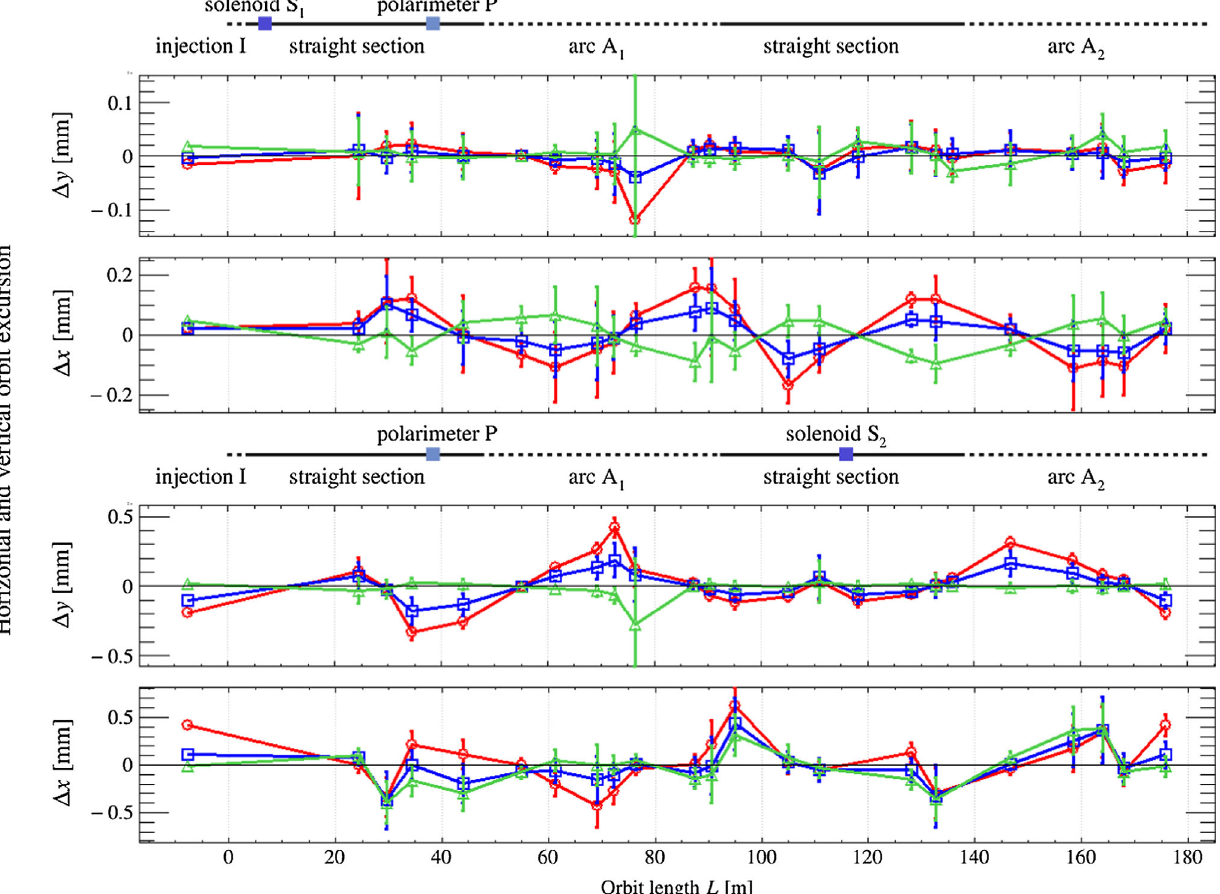
OFF.FIG. 5. Upper pair of panels: the experimentally observed horizontal and vertical orbit excursions along the ring for several spin kicks in solenoid S 1 ( χ 1 ¼ − 8 . 79 ð ○ Þ ; − 4 . 39 ð □ Þ ; 4 . 39 ð △ Þ mrad), while solenoid S 2 is switched off. The positions of solenoids S 1 and S 2 in the ring are indicated. The last BPM reading at the end of arc A 2 is replicated as first point of straight section I. The lines connecting the points are to guide eye. Bottom pair of panels: Measured horizontal and vertical orbit excursions along the ring for several spin kicks